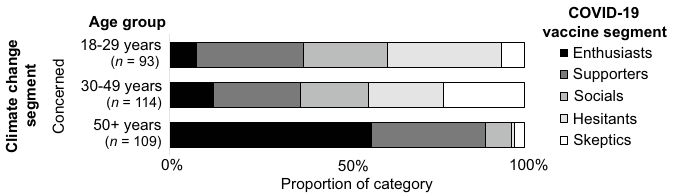
Figure 5. Vaccine segment distributions within the Concerned climate segment for each age group.